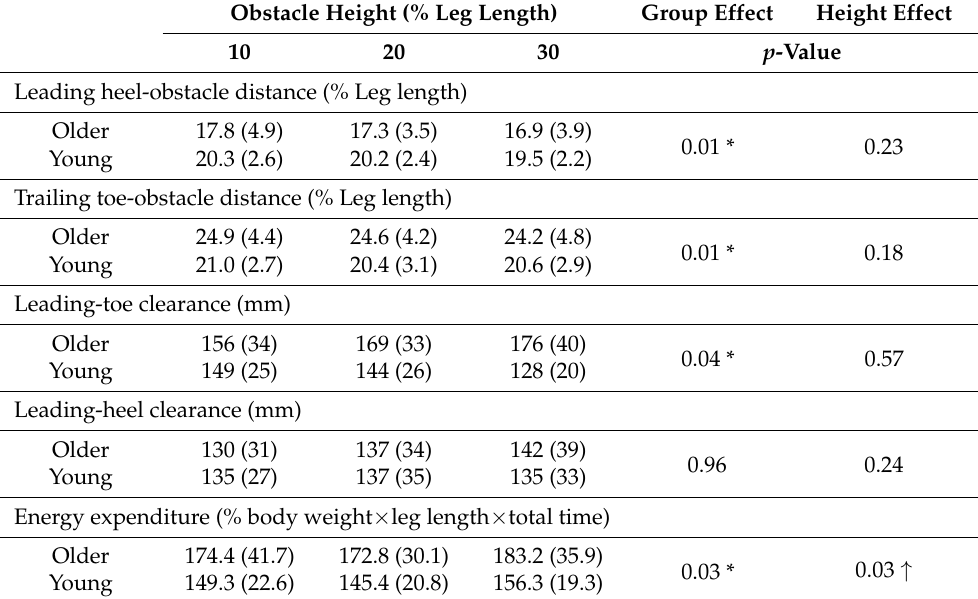
Table 2. Means (standard deviations) of the end-point variables and energy expenditure for the older and young control groups when crossing obstacles of three different